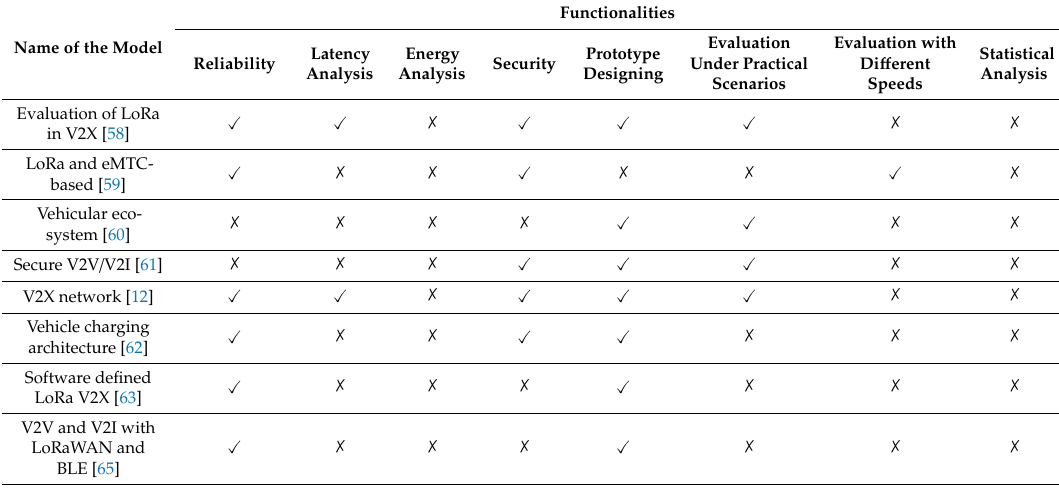
Table 8. Running time of OBU and RSU with 3.7v, 1000 mAh battery.